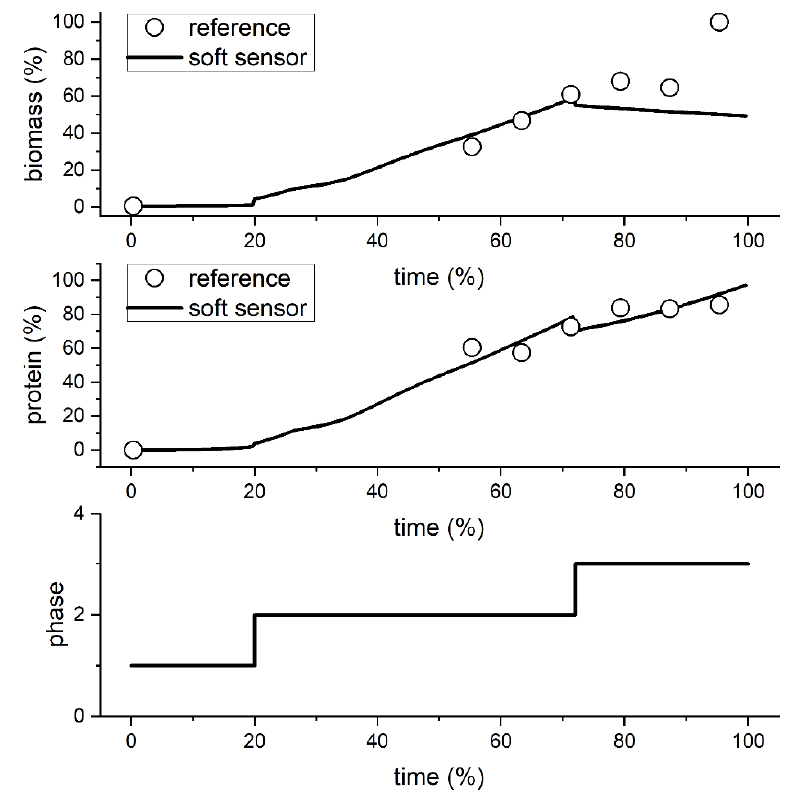
Figure 7. Prediction of the generalist soft sensor concept with reference values and detected phases for the biomass and protein prediction of an example data set of the B. subtilis process with CLA medium. Axes are in % due to confidentiality agreements.